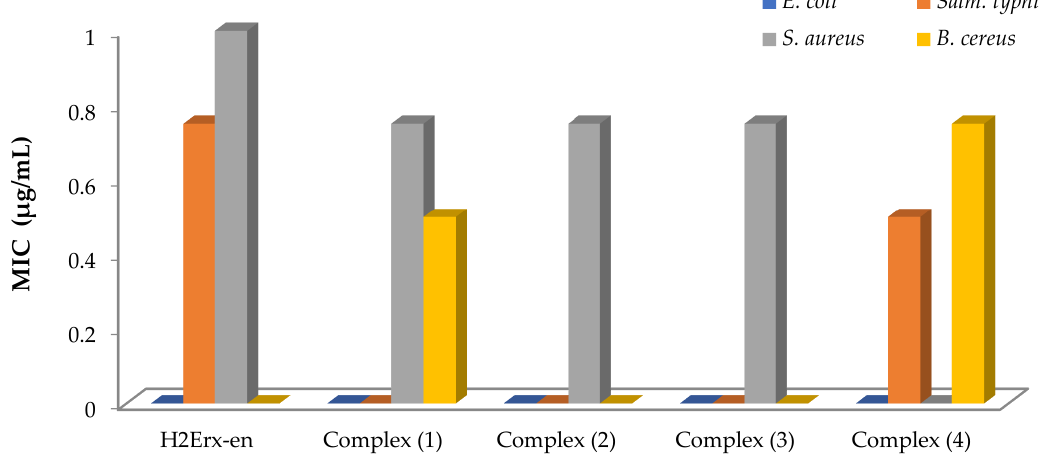
Figure 2. MIC for the sensitive bacteria for H 2 Erx-en and its metal complexes.